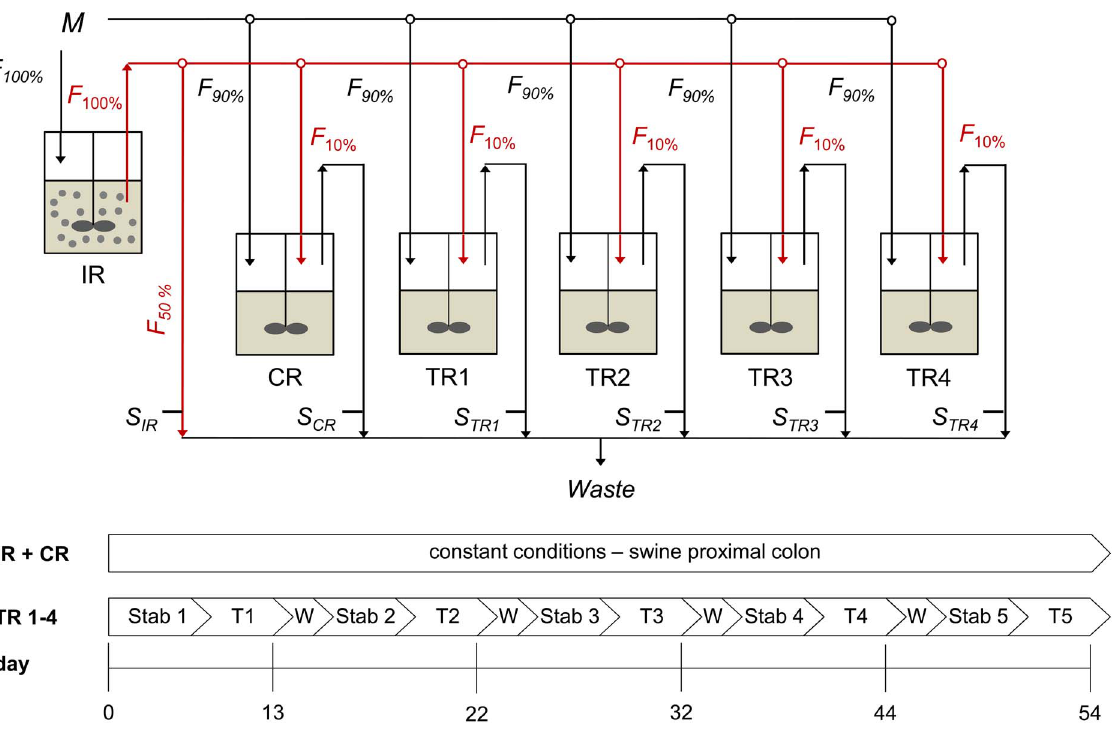
Figure 1. Experimental reactor set-up and time schedule of the swine PolyFermS model. IR: inoculum reactor, containing immobilized swine feces (30% v/v); CR: control reactor; TR1-TR4: test reactors 1-4; M : fresh nutritive medium supply; S : effluent sampling; F : flow rate; Stab: stabilization period; T: treatment period; W: wash period